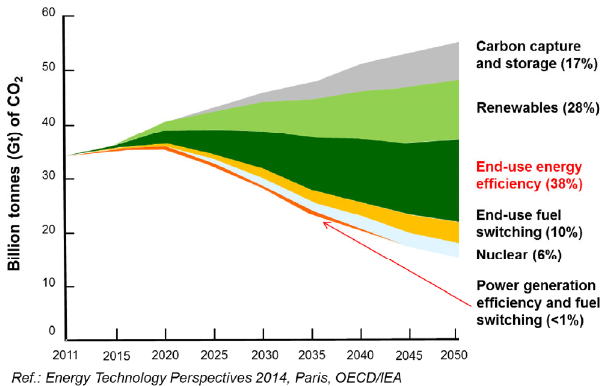
Fig. 1 Key technologies for reduction of CO 2 emissions in order to limit global warming to 2 ° C